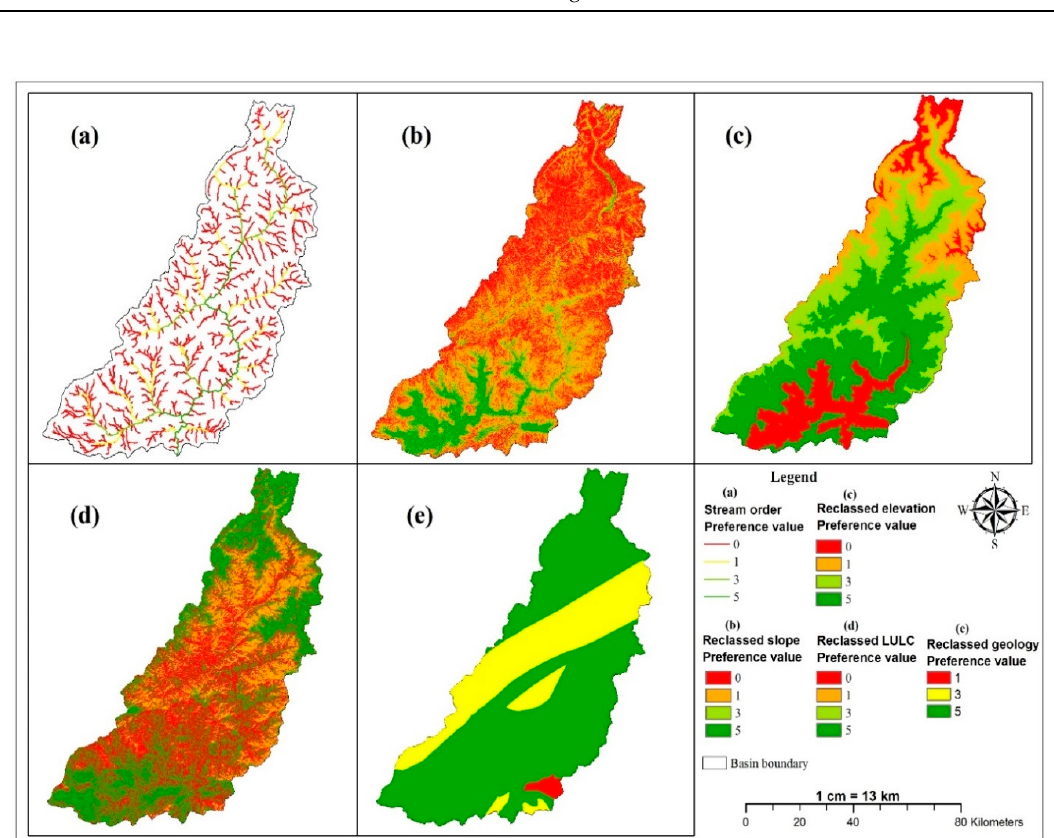
Figure 5. Reclassified layers: ( a ) stream order ( b ) slope ( c ) elevation ( d ) LULC ( e ) geology.